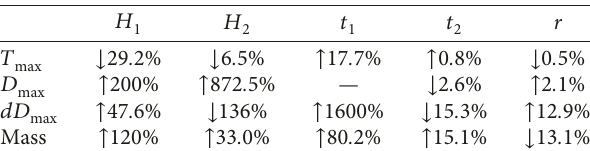
Figure 15: Effects of H on four responses. (a) Temperature T 1 Table 8: Sensitivity analysis results.